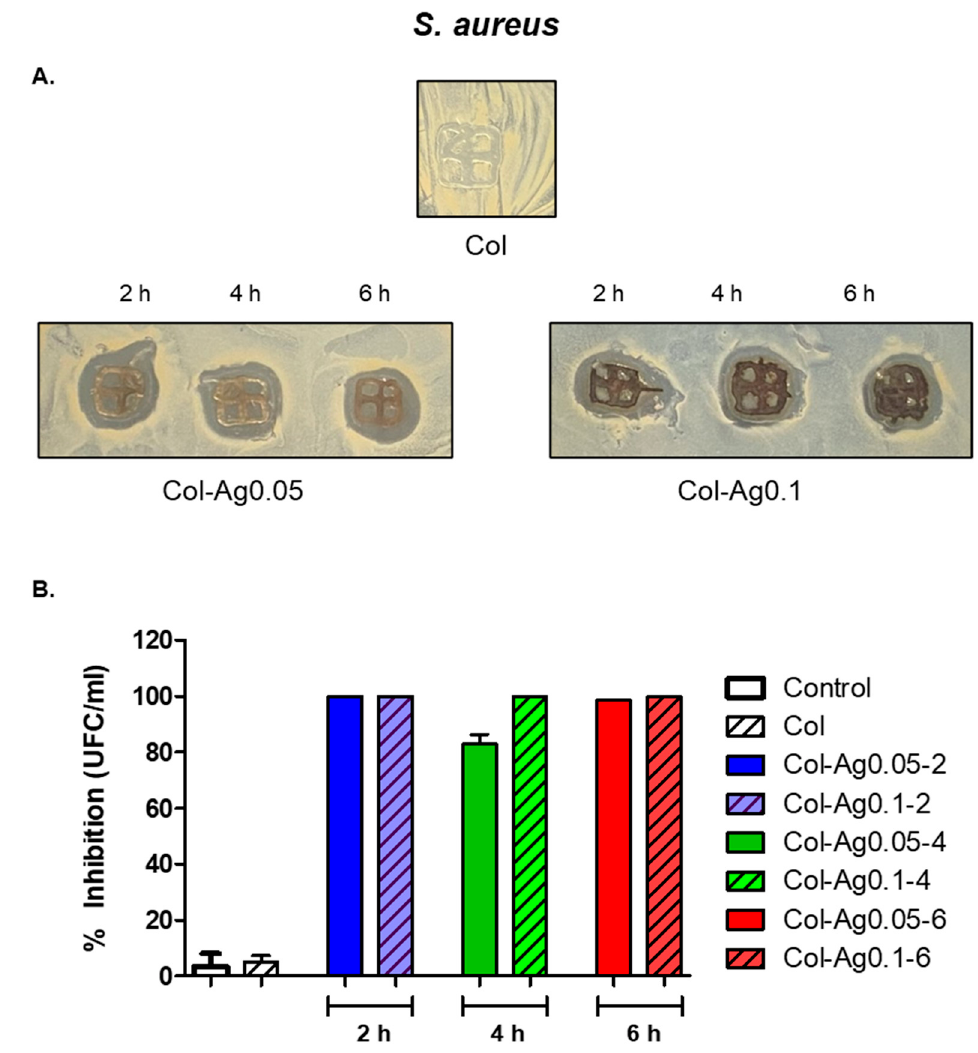
Figure 10. Antimicrobial activity of silver in 3D-printed Col and Col-Ag gels against S. aureus . ( A ) Disk diffusion method. ( B ) Percentage of growth inhibition, evaluated by the dilution method.